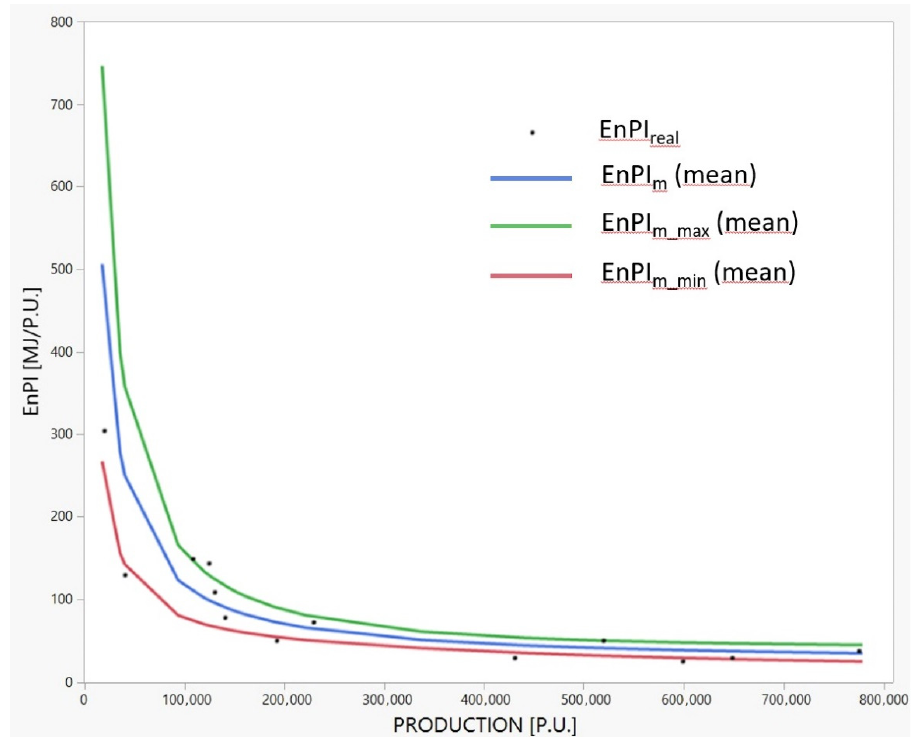
Figure 4. Mean, lower, and upper values of the EnPI model [MJ/P.U.] vs. Production [P.U.] and real EnPI for specific sites.